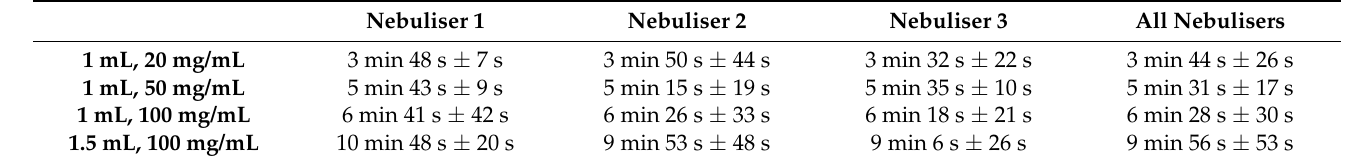
Table 6. Nebulisation duration of the cascade impaction experiments.